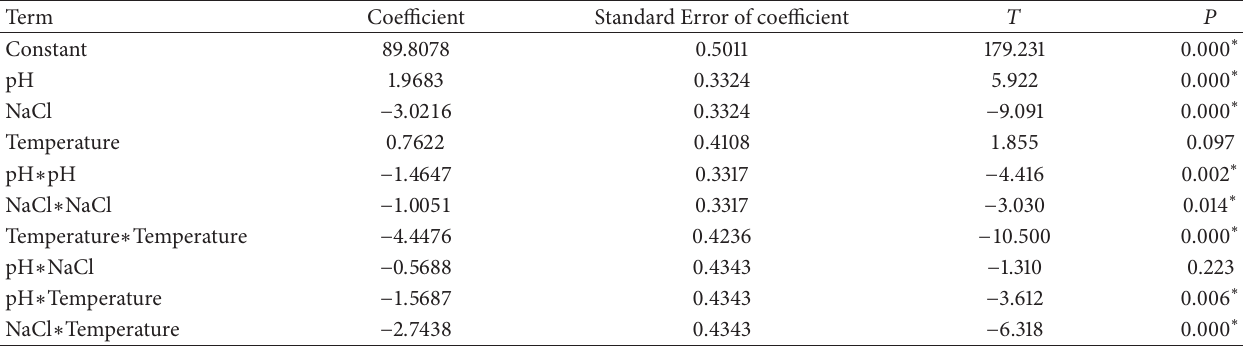
Table 6: Estimated regression coefficients for recovery (%) without outlier.